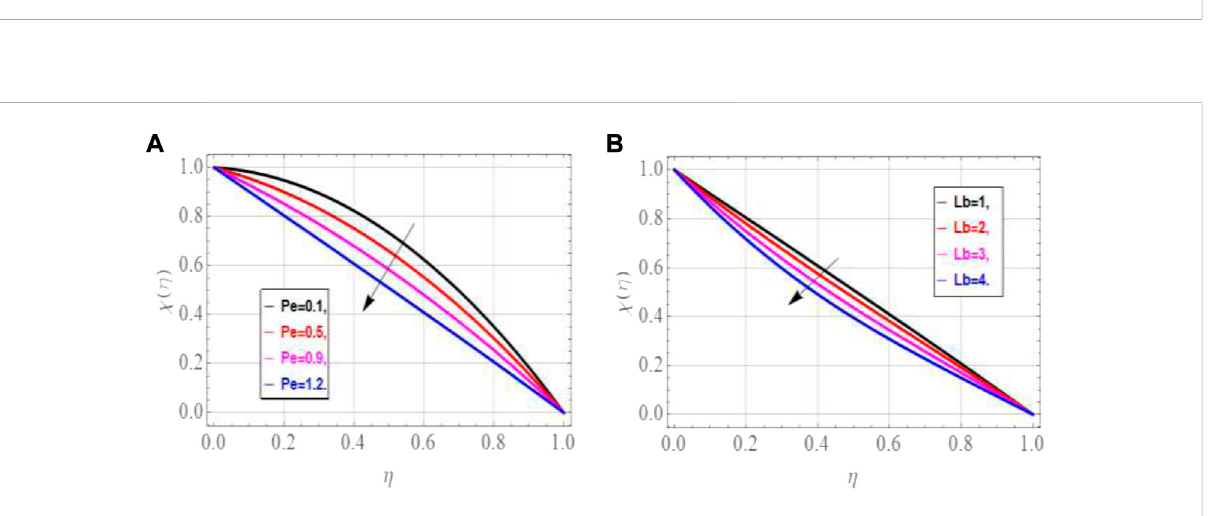
FIGURE 10 Impact of Pe , Lb on χ ( η )